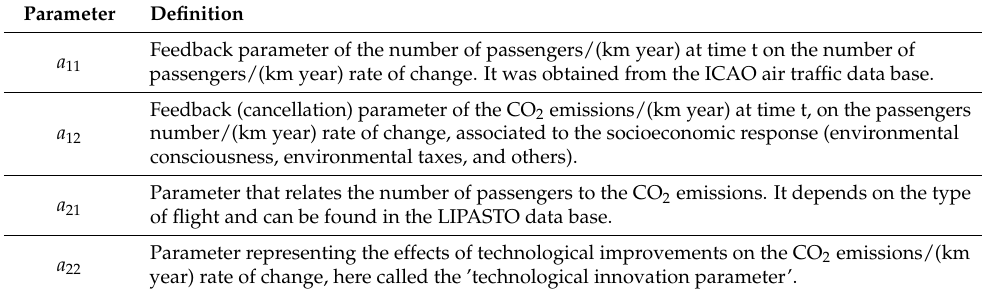
Table 1. Model parameter